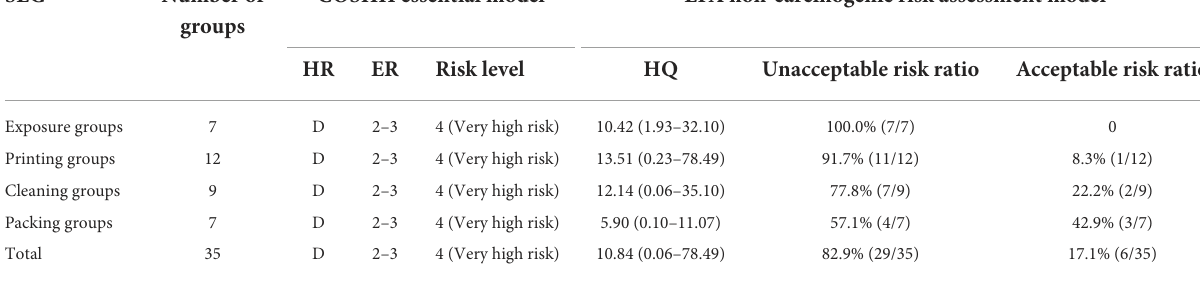
TABLE 2 Evaluation results of the COSHH Essential model and the EPA non-carcinogenic risk assessment model of